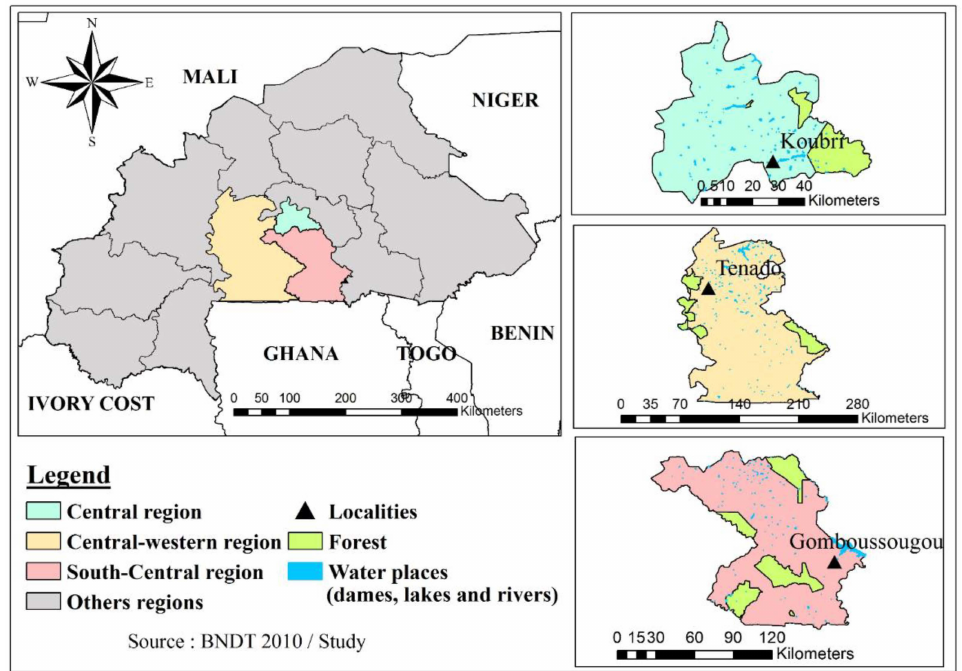
Figure 1. Map of the farms in Burkina Faso. The three farms are located in three different areas: central region (in light blue), central–western region (in light orange), and southern–central region (in light pink). For each of the three regions, localities are indicated by triangles, forests are indicated in green, and water resources are shown in